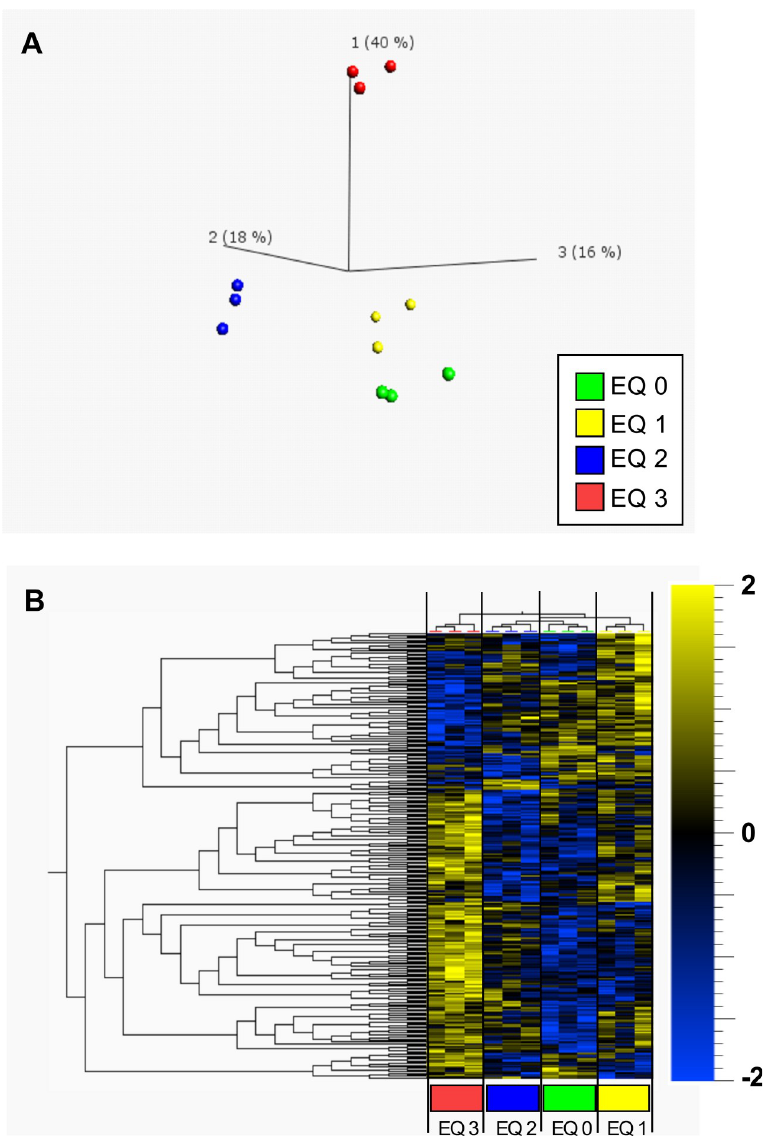
Fig 6. Principal component analysis (PCA) and hierarchical clustering (HC) of 287 significantly regulated ( p < 0.05, ANOVA) proteins in livers of Atlantic salmon ( Salmo salar L.) exposed to graded levels of ethoxyquin (EQ) through their diet for 90 days. Differential analysis (ANOVA), PCA (A) and HC (B) were performed using the Qlucore omics-explorer. The heatmap (B) represents the concentrations of significantly regulated proteins within each measured sample (represented in the columns). Yellow bars indicate higher concentrations of a protein, while blue bars indicate lower concentrations of a protein, on a scale from -2 to 2, where 1 unit is equal to a variance of 1 from the mean. See S9 Table for a complete overview of individual